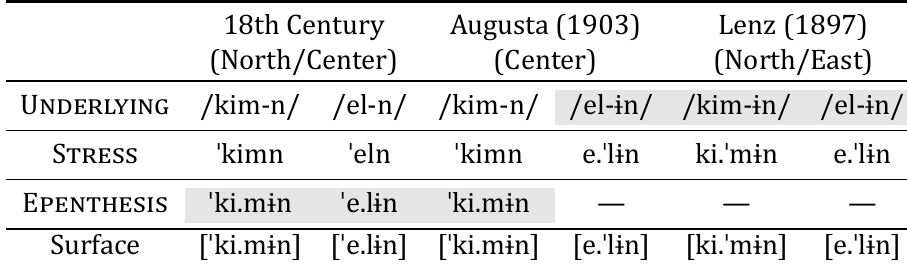
Table 17: Dialectal (and historical) differences in the position of stress in conosnant- (cid:976)inal roots with a [ə] (cid:24) [ɨ] vowel preceeding [-n] ‘-(cid:270)(cid:275)(cid:265).1(cid:280)’ marking (Examples: [kim-ɨn] ‘know-(cid:270)(cid:275)(cid:265).1(cid:280)’; [el-ɨn] ‘place-(cid:270)(cid:275)(cid:265).1(cid:280)’